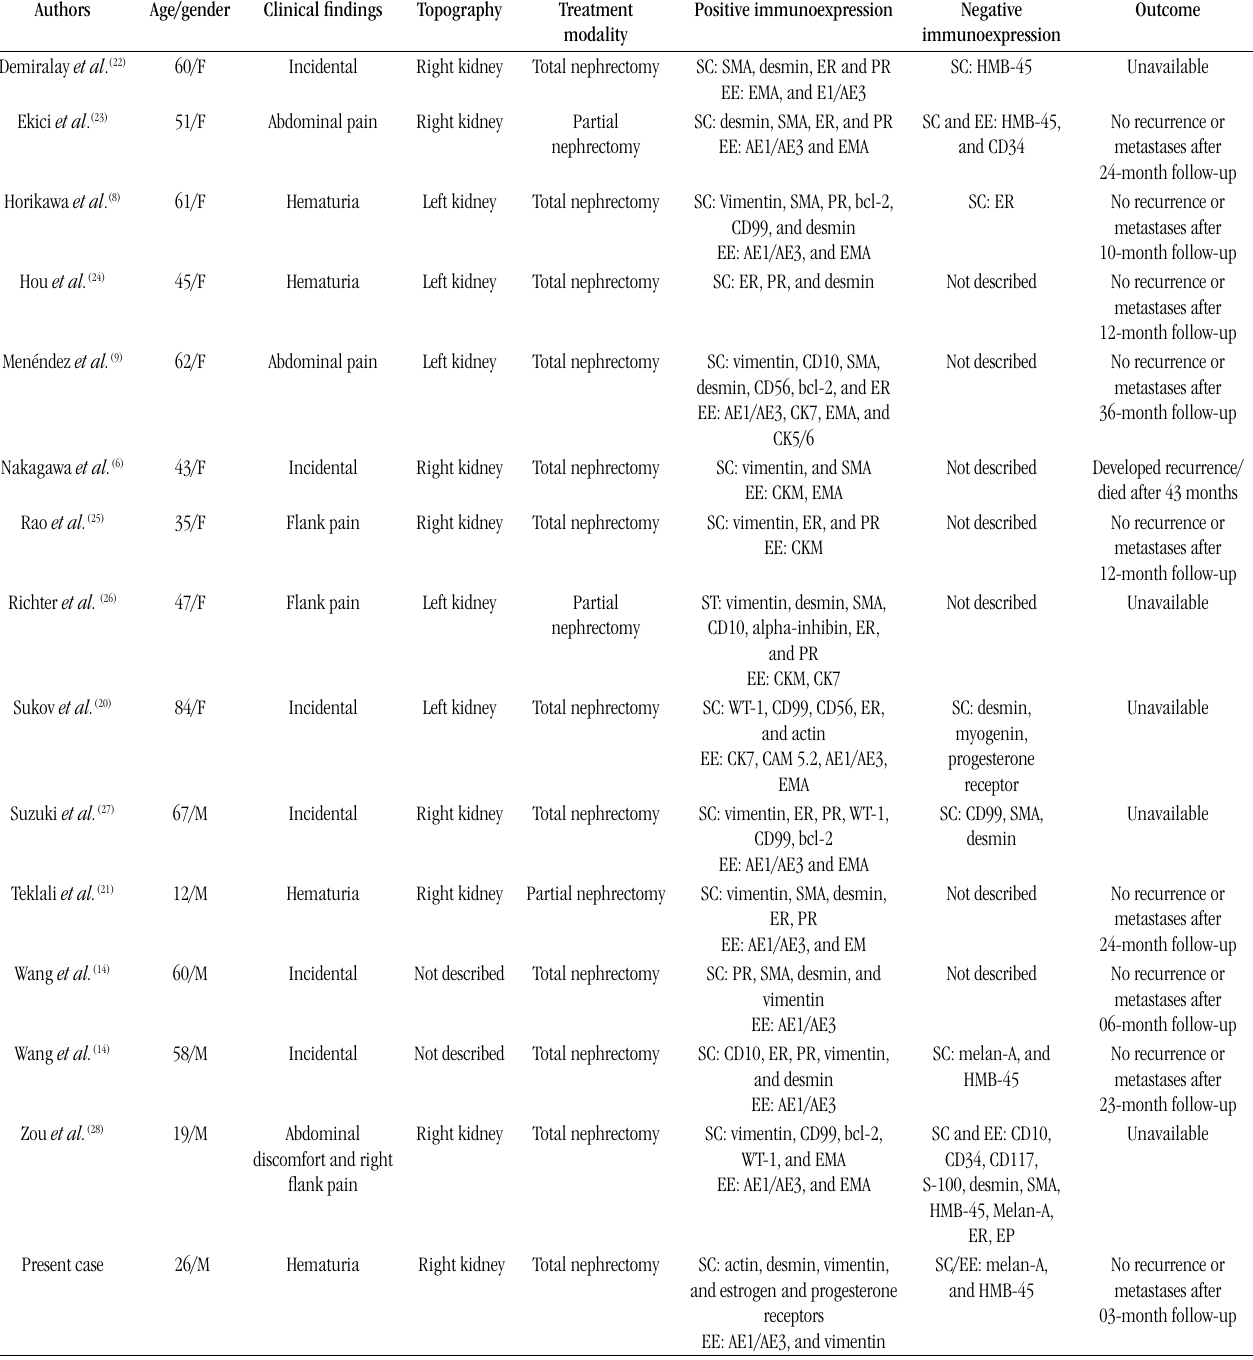
taBLE – Summary of published cases of MEST of the